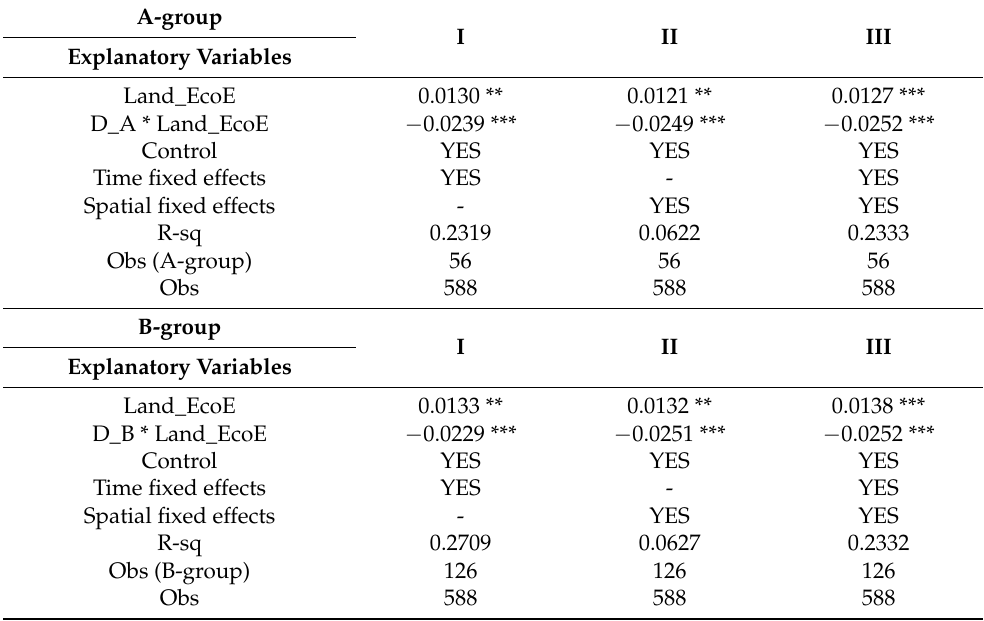
Table 4. Further regression for the spatio-temporal fixed effects of land economic